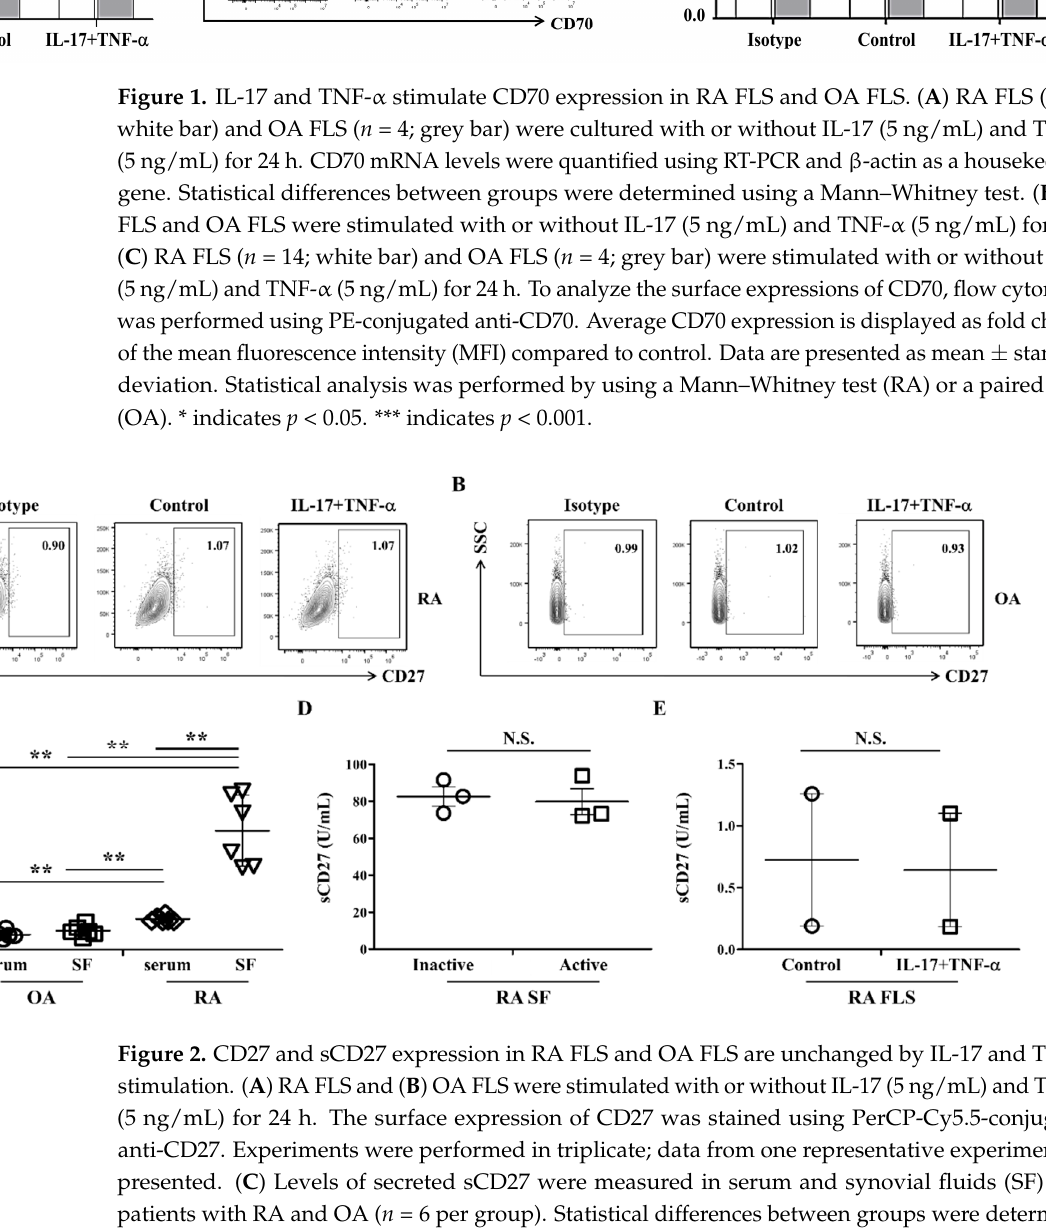
( C ) RA FLS ( n = 14; white bar) and OA FLS ( n = 4; grey bar) were stimulated with or without IL-17 (5 ng/mL) and TNF- α (5 ng/mL) for 24 h. To analyze the surface expressions of CD70, flow cytometry was performed using PE-conjugated anti-CD70. Average CD70 expression is displayed as fold change of the mean fluorescence intensity (MFI) compared to control. Data are presented as mean ± standard deviation. Statistical analysis was performed by using a Mann–Whitney test (RA) or a paired t -test (OA). * indicates p < 0.05. *** indicates p < 0.001.